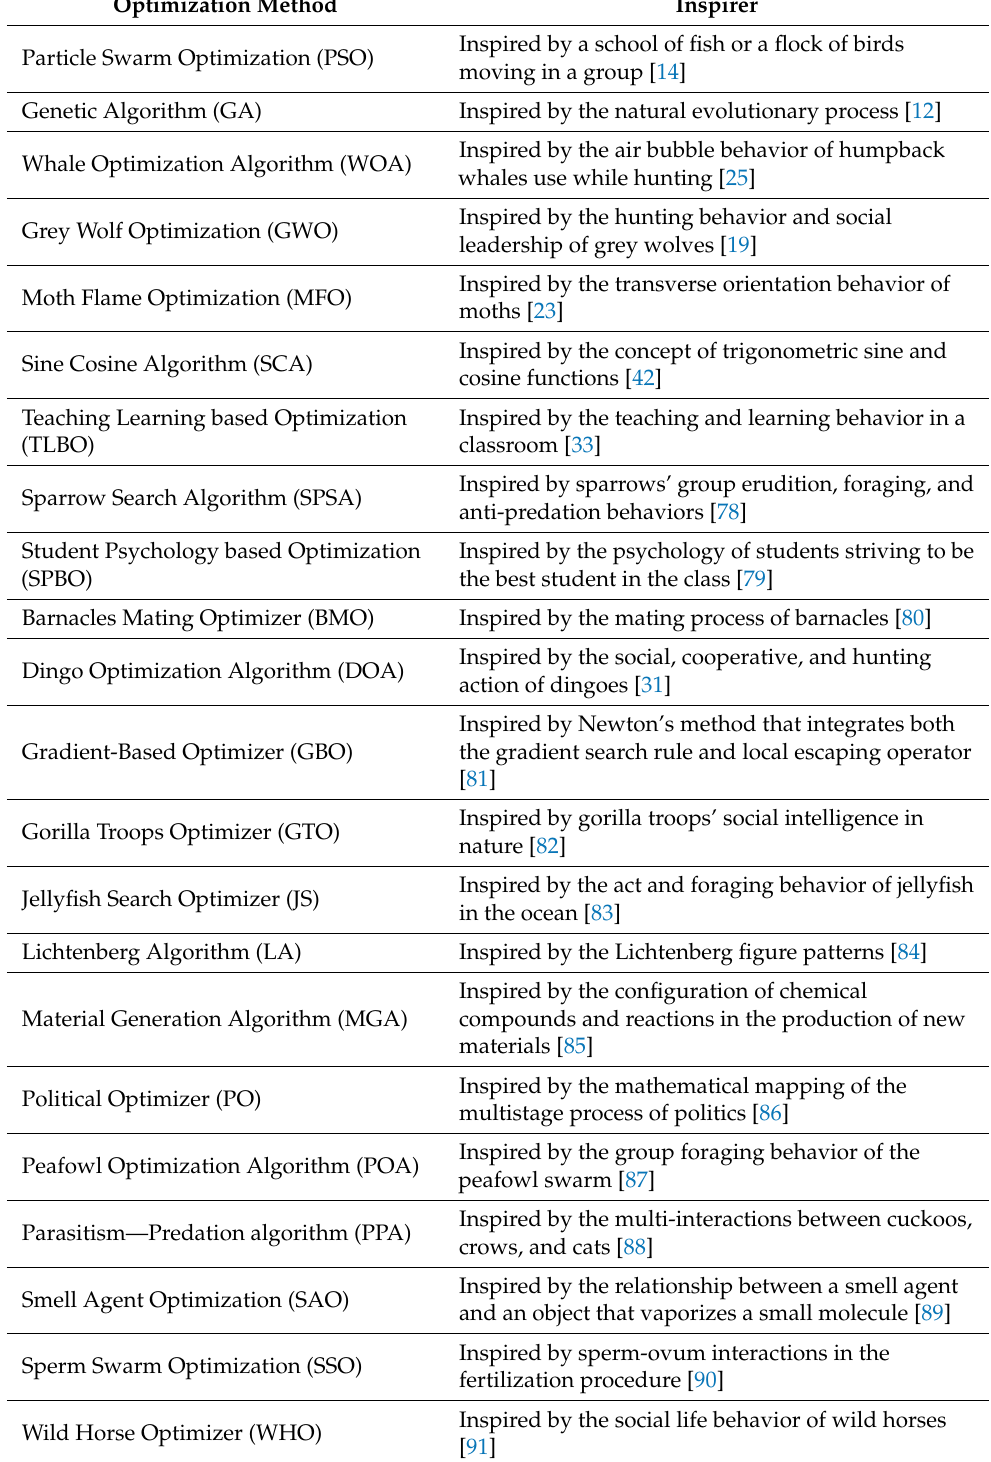
Table 1. A summary of the metaheuristic